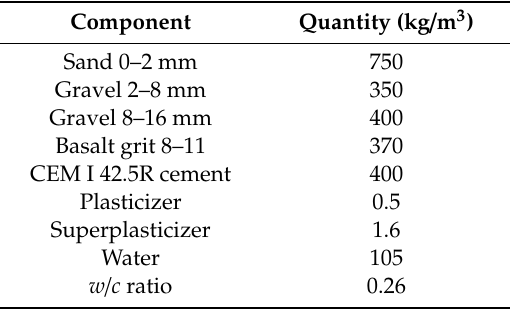
Table 1. Recipe for concrete mix used in the production of E10.5 / 6c